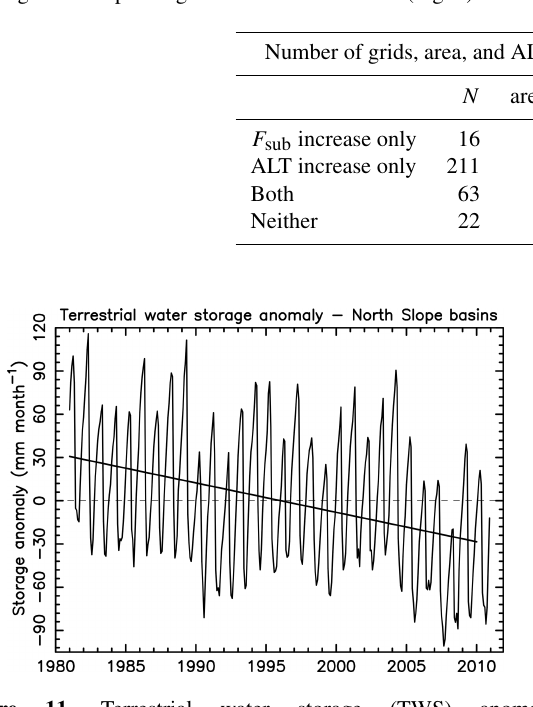
Figure 11. Terrestrial water storage (TWS) anomaly (mmmonth − 1 ) as an average across the North Slope drainage basin. Anomaly calculated with respect to the long-term 1981– 2010 average. In the PWBM, TWS includes soil liquid water, ice, and snow storage. It does not include water stored in permanent water bodies such as ponds and lakes.